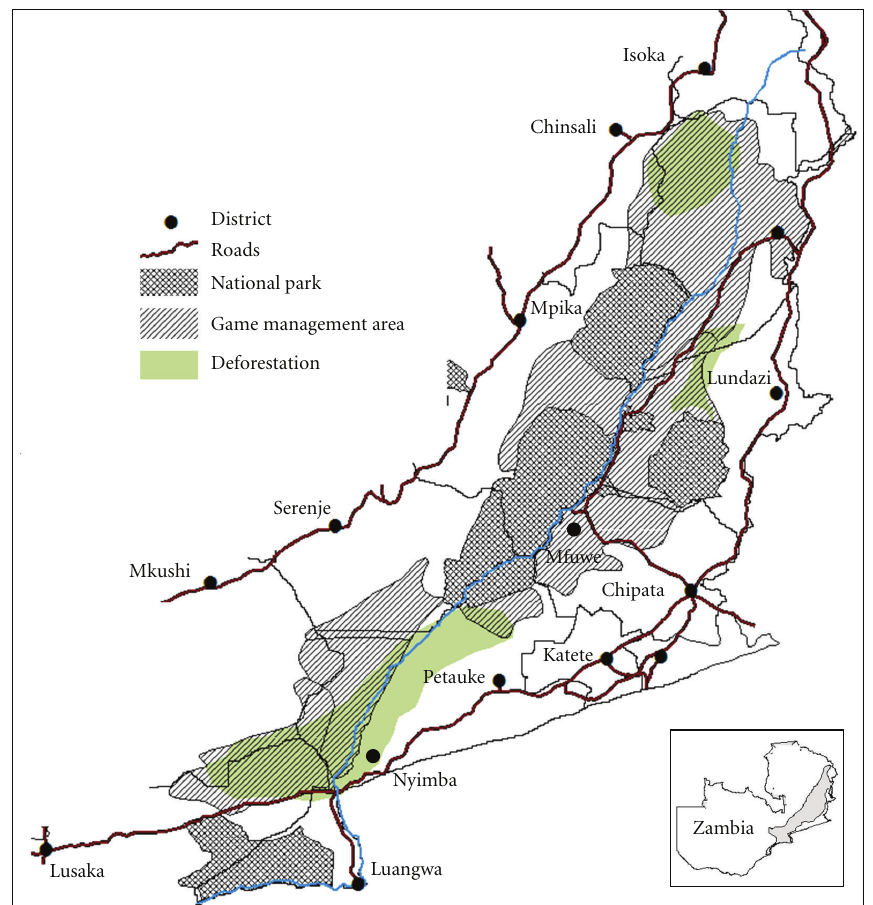
Figure 3: Shows the districts surrounding the National Parks and Game Management areas (GMAs) and deforestation in the GMAs. Inset shows the map of Zambia and study